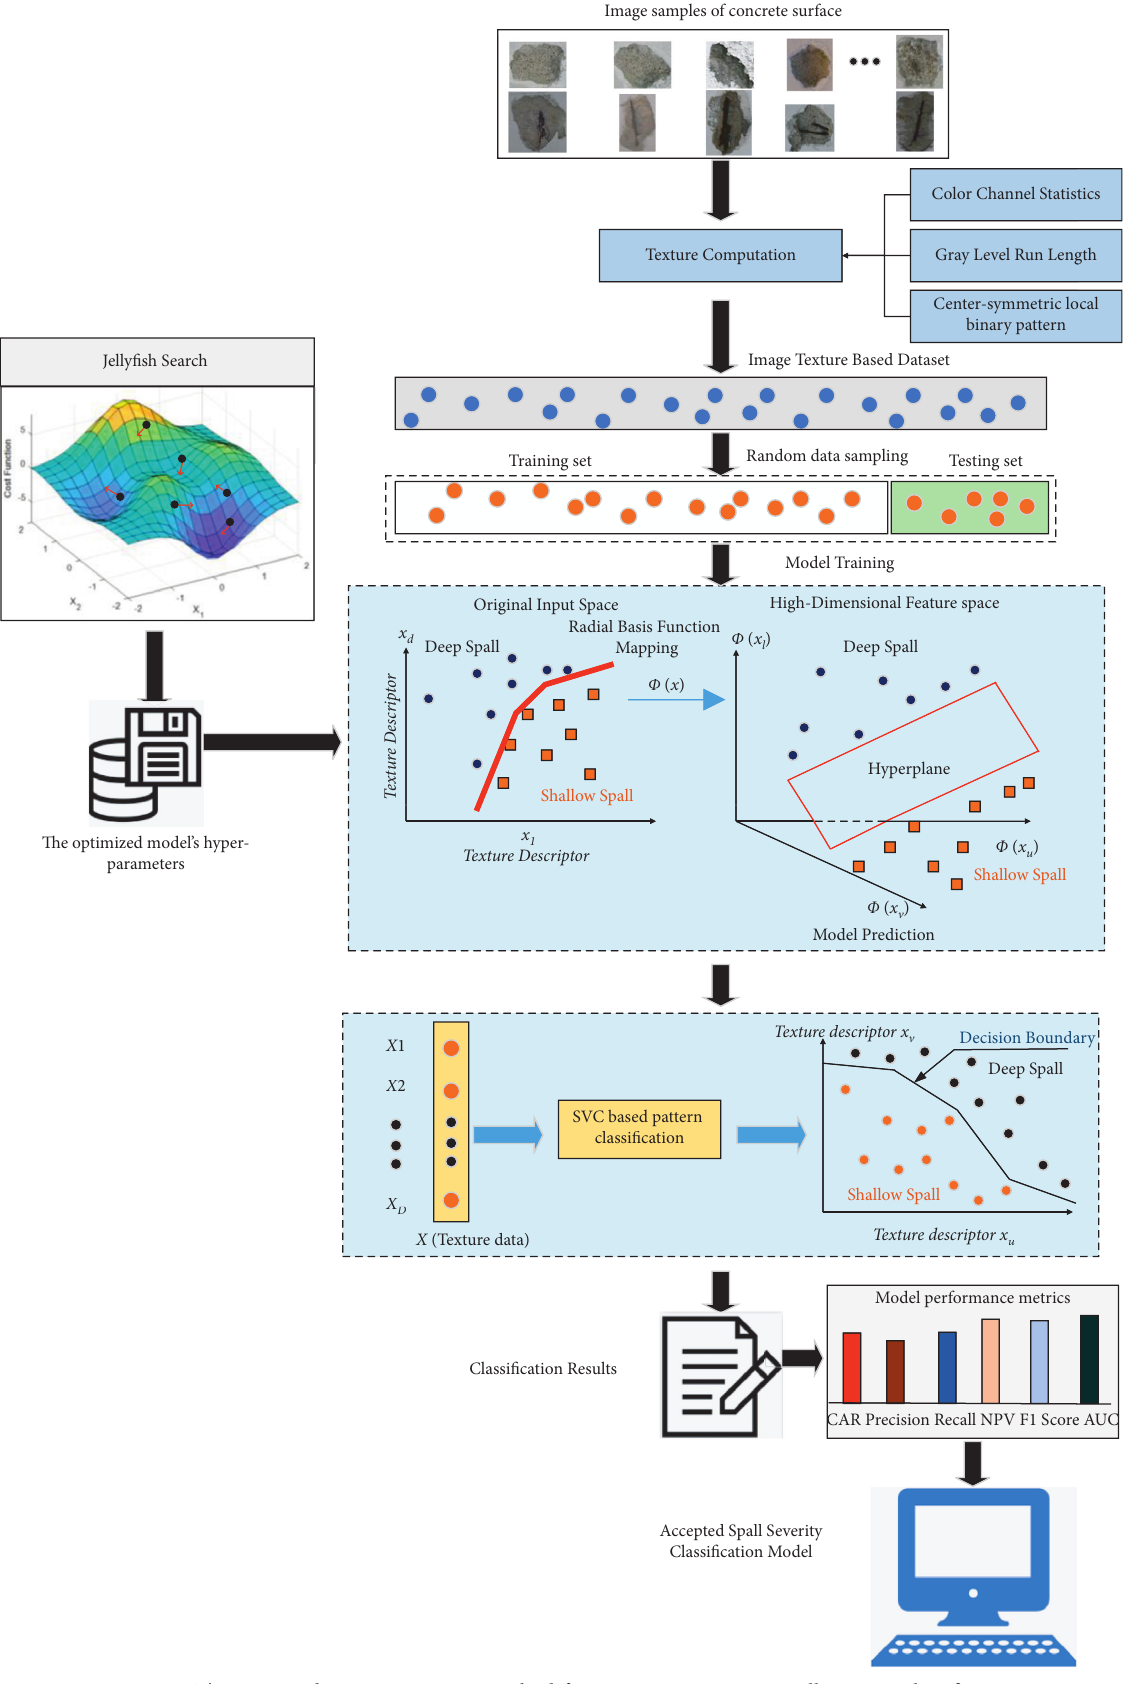
Figure 6: The proposed computer vision method for automatic concrete spall severity